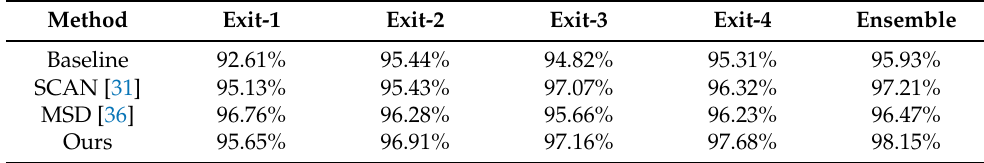
Table 4. Classification accuracy by different exit and